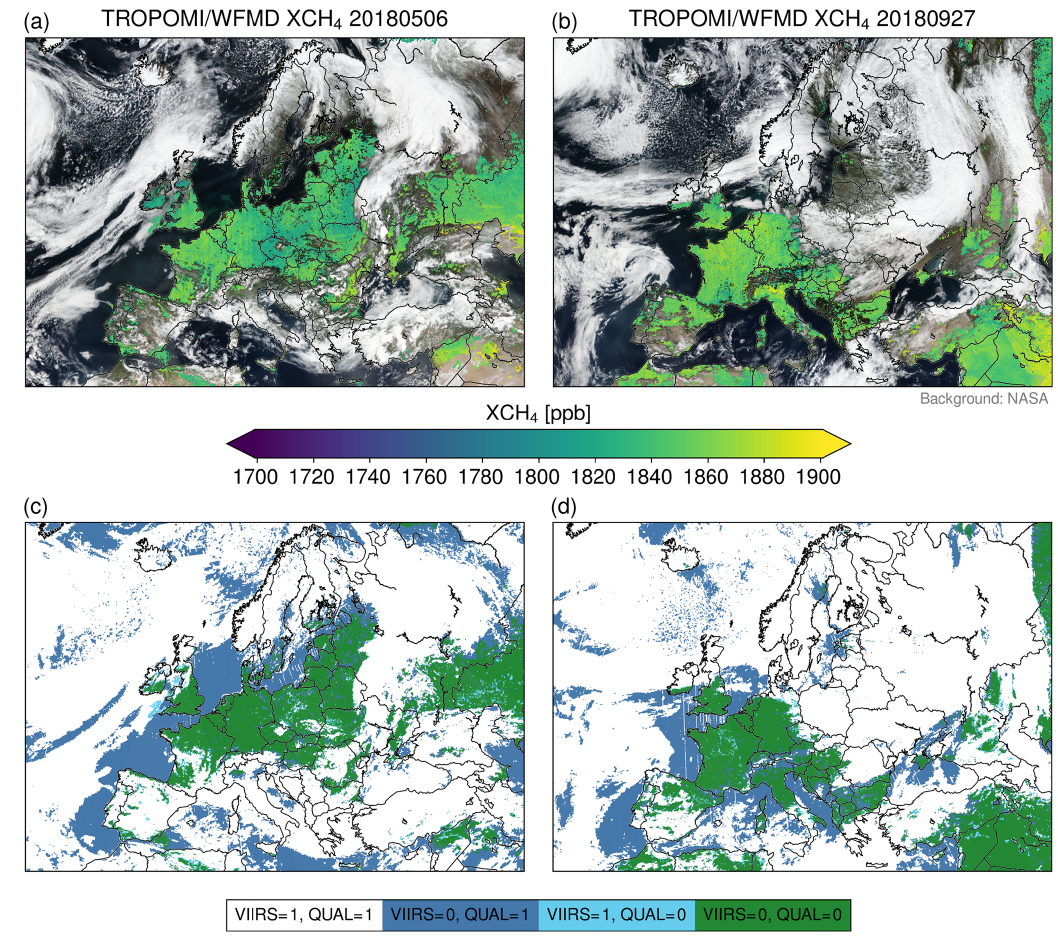
Figure 8. (a, b) Quality-filtered XCH 4 over Europe overlaid on true colour reflectances from the Visible Infrared Imaging Radiometer Suite (VIIRS) taken from the NASA Worldview application for two example days not included in the training data set, demonstrating the perfor- mance of the machine-learning classification algorithm. Evidently, cloudy scenes are typically identified and excluded. (c, d) Comparison of the implemented quality filter (QUAL, 1: excluded) with the VIIRS cloud classification (1: cloudy). Matching classifications are shown in white and green. By definition the quality filter is generally stricter than the VIIRS cloud flag and the blue areas are additionally excluded. The rare instances of measurements classified as cloudy by VIIRS but still passing the quality filter are shown in